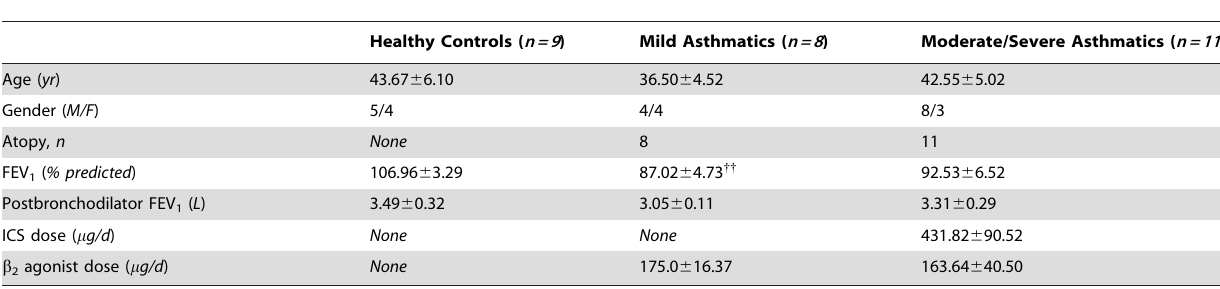
Table 1. Demographic and clinical characteristics of non-smoking patients with asthma and non-atopic healthy